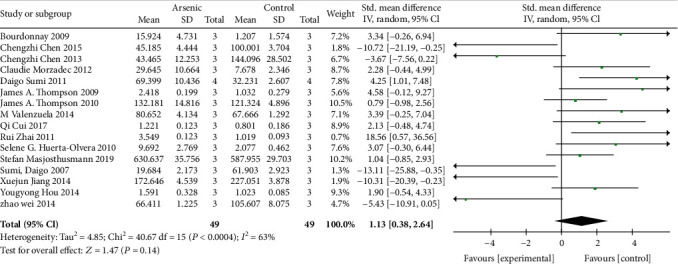
Meta-analysis of the effect of arsenic on the GCLM of r-GCS subunits in vitro. The forest plot shows the effect of arsenic treatment on GSH in the experiment and control group. SMD: standardized mean difference; IV: independent variable; 95% CI: 95% confidence interval; SD: standard deviation. The P value of the overall test effect is 0.14; when P < 0.05, the difference was considered statistically significant.